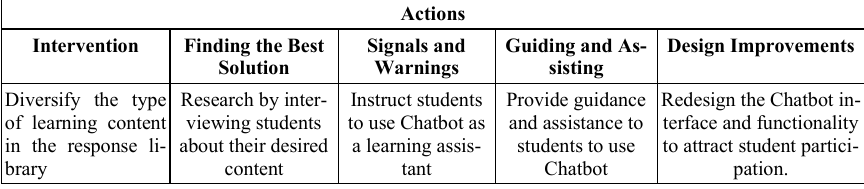
Table 2. Proposed